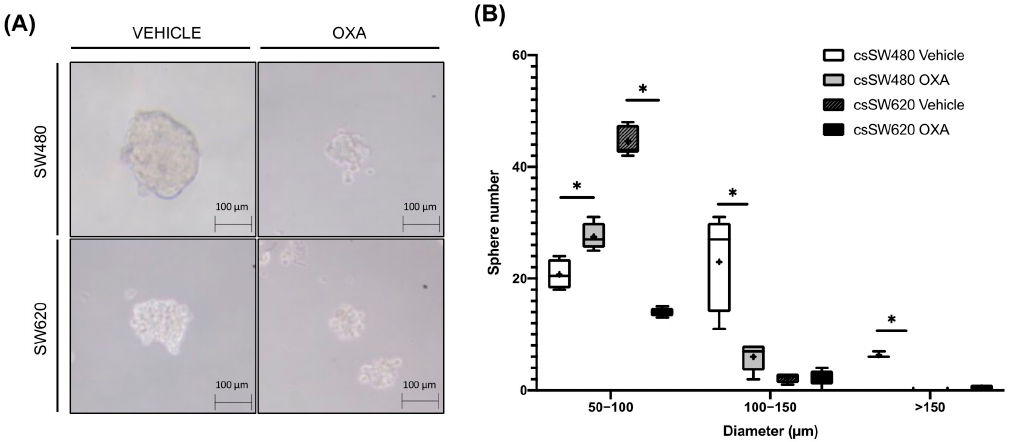
Figure 2. ( A , B ) Representative images of SW480 and SW620 tumourspheres after 96 h of vehicle (0.1% DMSO) or oxaliplatin 5 µM treatment for SW480 and SW620 tumourspheres after 96 h of oxaliplatin treatment. Each box represents the interquartile range (25th to 75th percentiles), the cen- tral horizontal line is the median value, and the whiskers represent the minimum and the maximum values ( n ≥ 4). Student’s test or Mann–Whitney test were performed to determine the significance between the experimental groups. Statistical significance was set at * p < 0.05. To further evaluate the presence of CRC-CSCs in the tumourspheres and their stem- markers were analysed. As seen in Figure 3A, SW620 tumourspheres presented higher